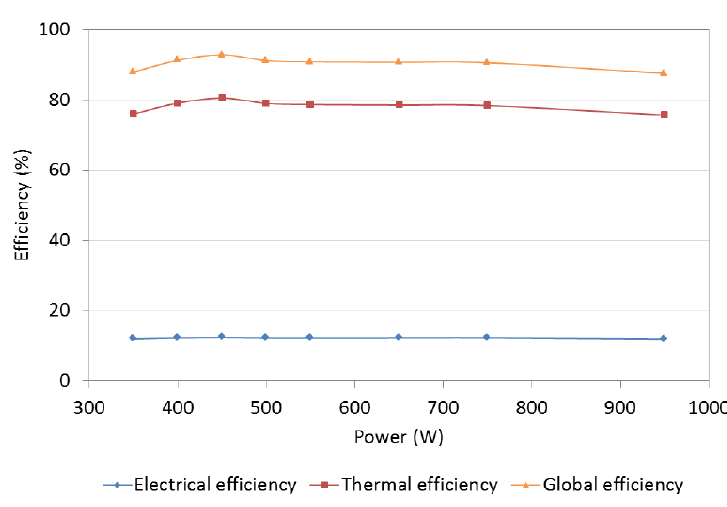
Figure 5. Efficiencies with different loads.